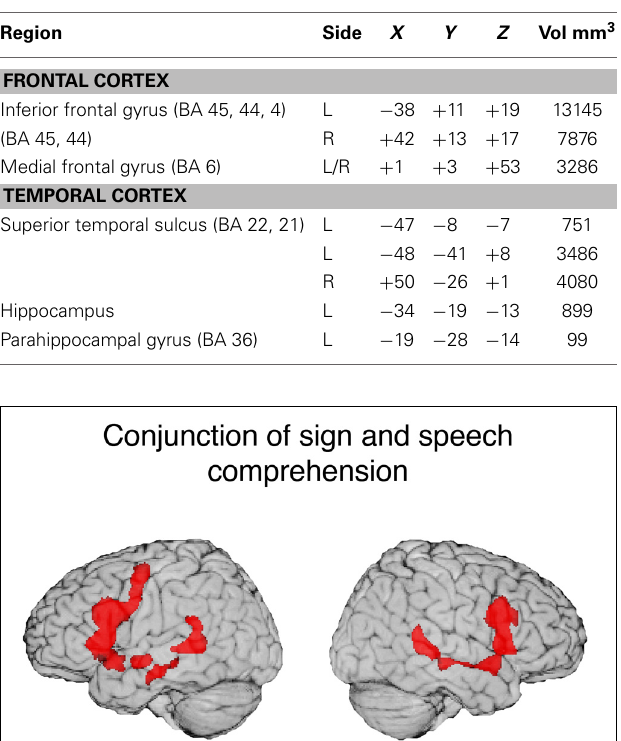
Table 3 | Center of mass Talairach coordinates and cluster volumes for the conjunction of sign and spoken language comprehension (each vs. its baseline; thresholded at q = 0 . 001).